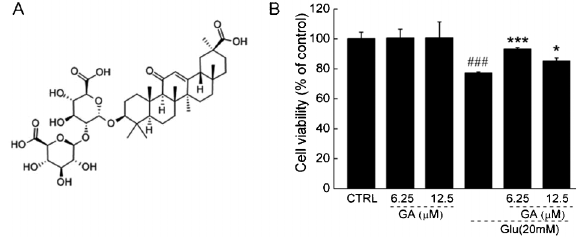
Figure 1. A , Chemical structure of glycyrrhizic acid (GA). B , GA enhanced cell viability in differentiated PC12 cells exposed to glutamate (Glu). Differentiated PC12 cells were pre-treated with GA for 3 h and then co-treated with or without Glu for another 24 h. Data are reported as a percentage (means±SD) of that from corresponding control cells (CTRL) (n=3). ### P , 0.001 vs CTRL; *P , 0.05 and ***P , 0.001 vs Glu-treated cells (one-way ANOVA followed by Dunn 9 s